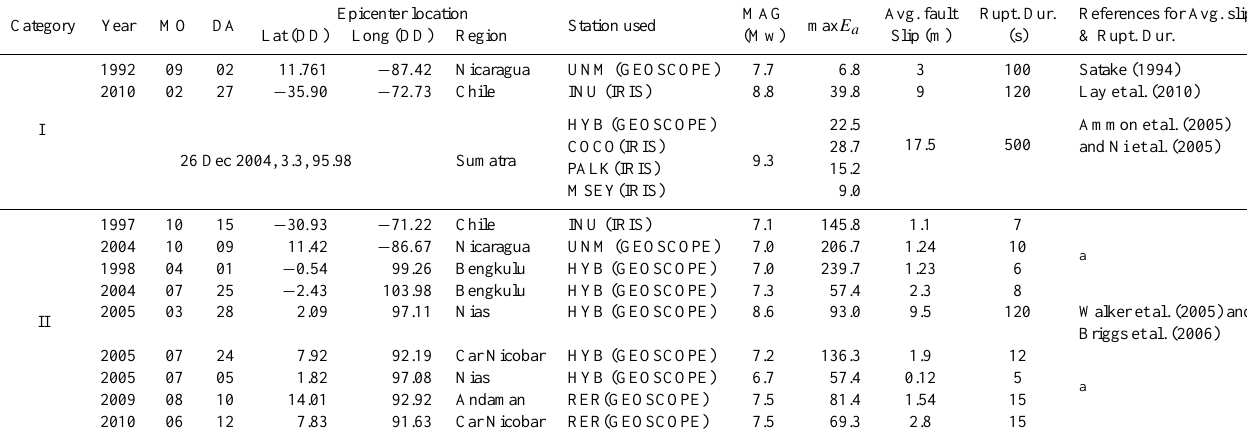
Epicenter location MAG Avg. fault Rupt. Dur. References for Avg. slip Category Year MO DA Station used max E a Lat (DD) Long (DD) Region (Mw) Slip (m) (s) & Rupt.